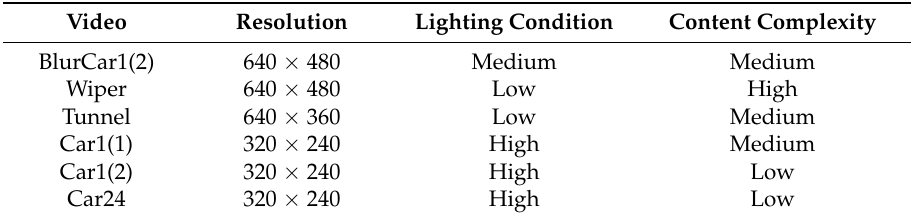
Table 3. Test video